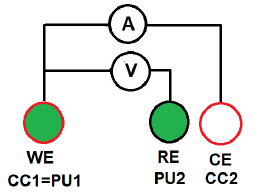
Figure 3. Schematic of a three electrode configuration set up, where an external voltage is applied between the reference (RE) and the working electrode (WE), and electric current is passed from the counter electrode (CE) to the working electrode (WE).